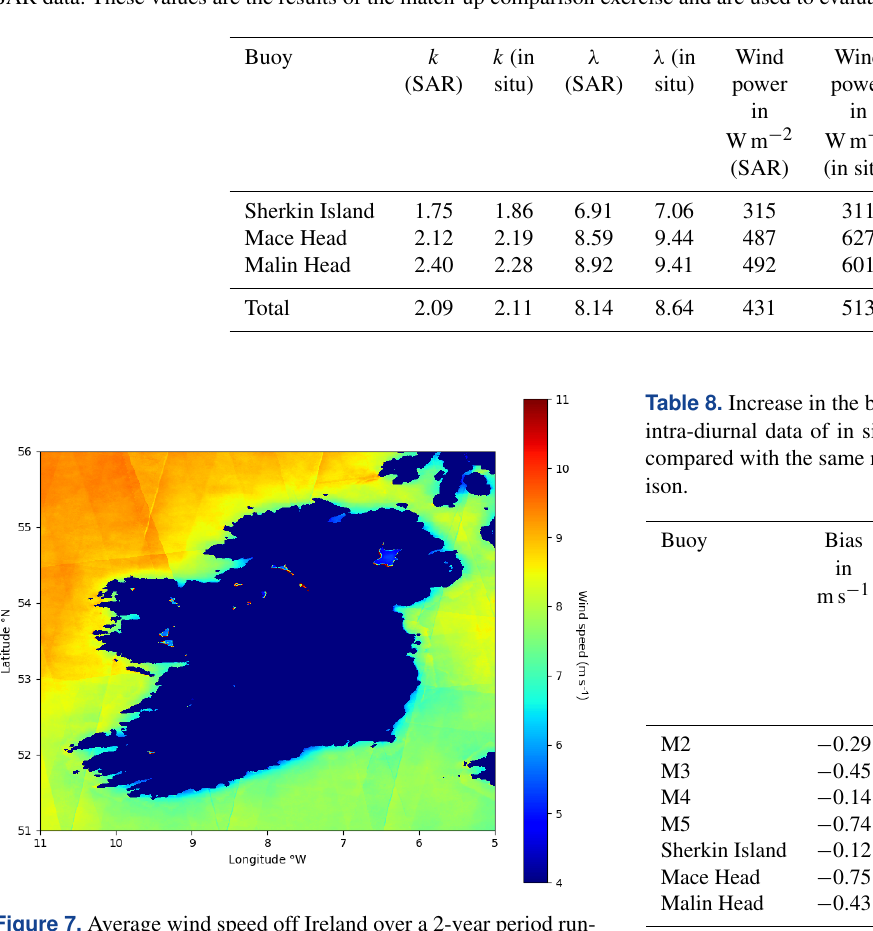
Figure 7. Average wind speed off Ireland over a 2-year period run- ning from May 2017 to May 2019 retrieved using the Sentinel-1 SAR Level 2 OCN product. Satellite tracks are visible, particularly in the northeast. These are an artefact of the analysis.